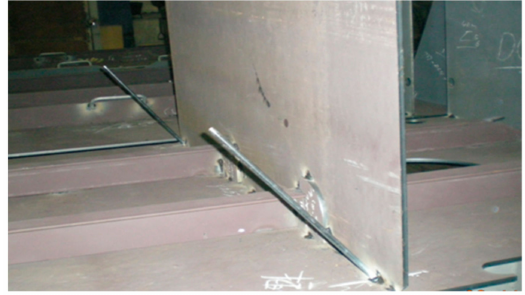
Figure 14. Ironwork PIECE